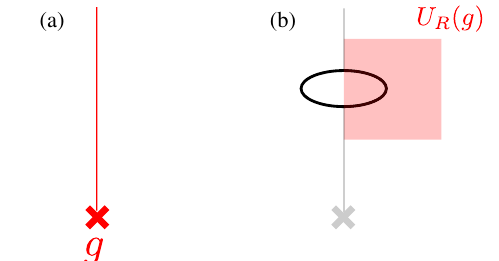
FIG. 7. (a) A symmetry flux for a symmetry g consists of a line terminating at a point. (b) Terms of the Hamiltonian (shown as an oval) that cross the line get conjugated by the unitary action, restricted to act only one side of the line [denoted by U